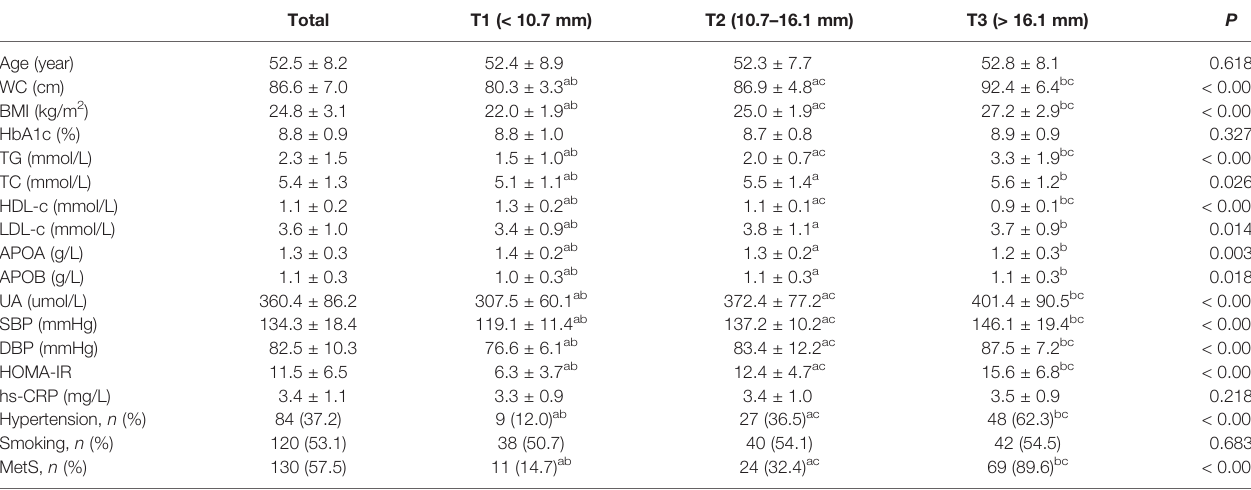
TABLE 1 | The characteristics of newly diagnosed T2DM were divided into three groups based on tertiles of PrFT in men.